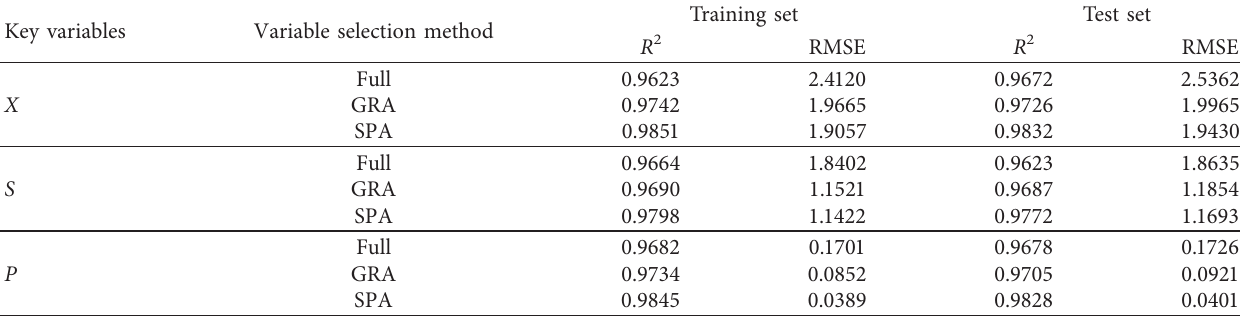
Table 3: Comparison of different variable selection